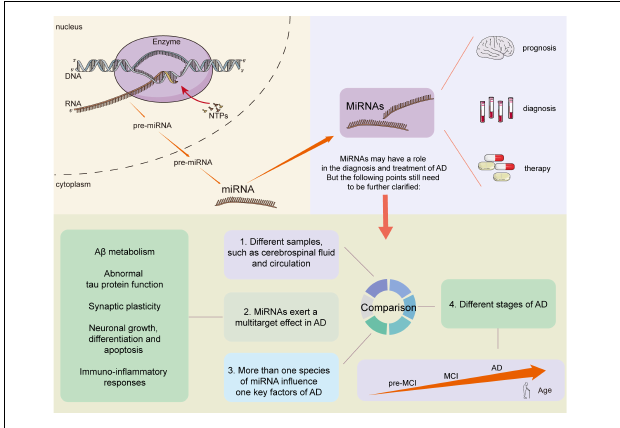
FIGURE 2 | MiRNAs play a role to diagnose